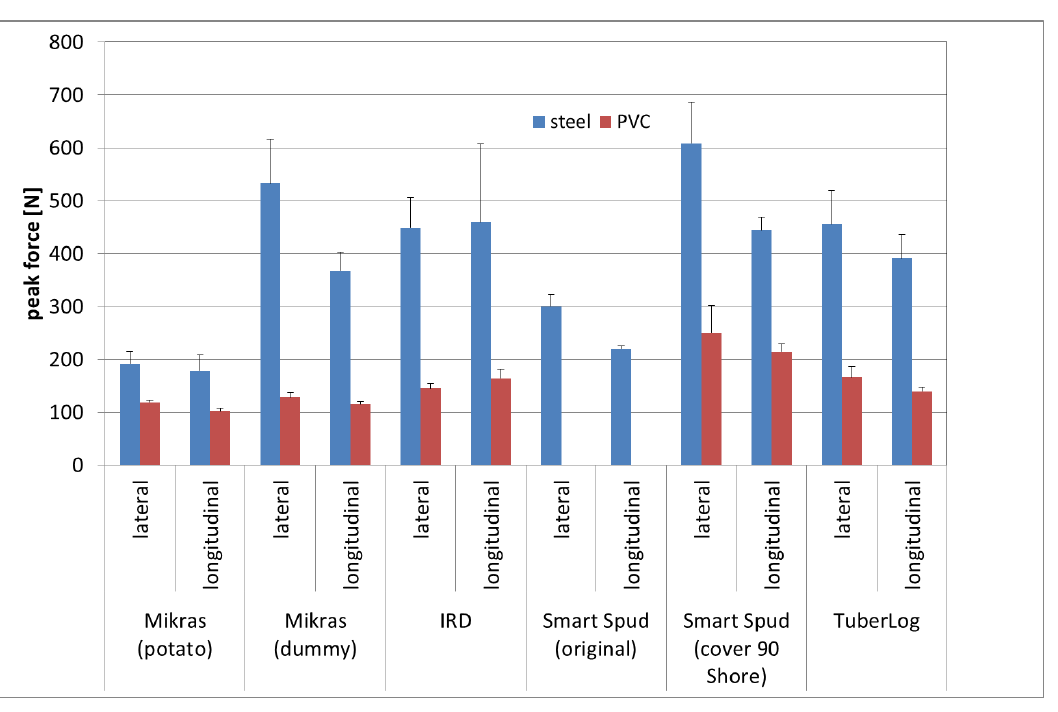
Figure 7. Peak force (drop simulator) for impacts of different electronic fruits (drop height 10 cm in different fall directions onto steel or